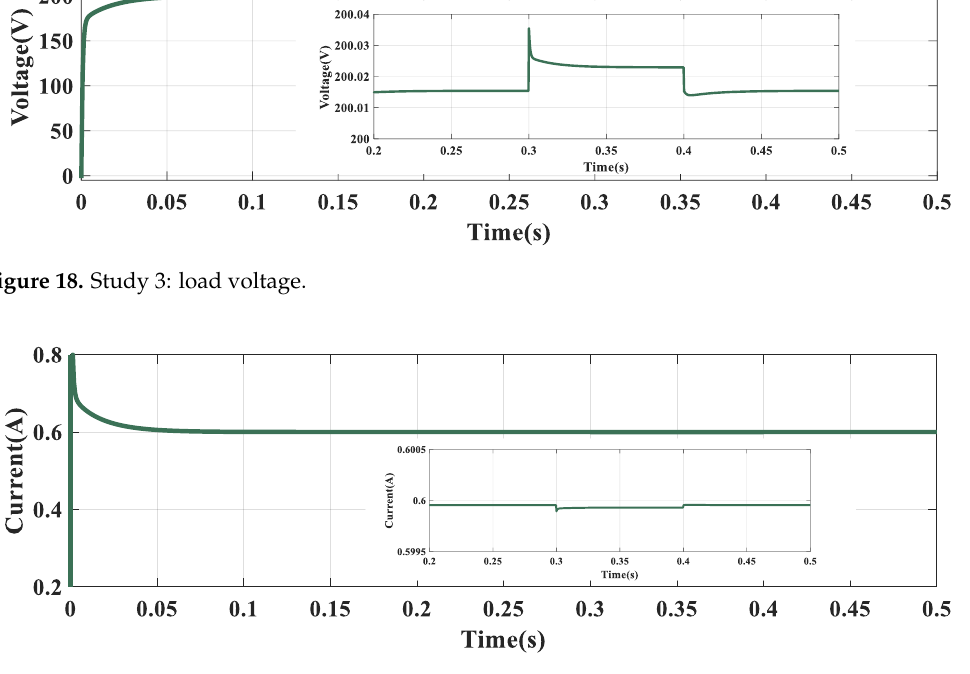
Figure 19. Study 3: load